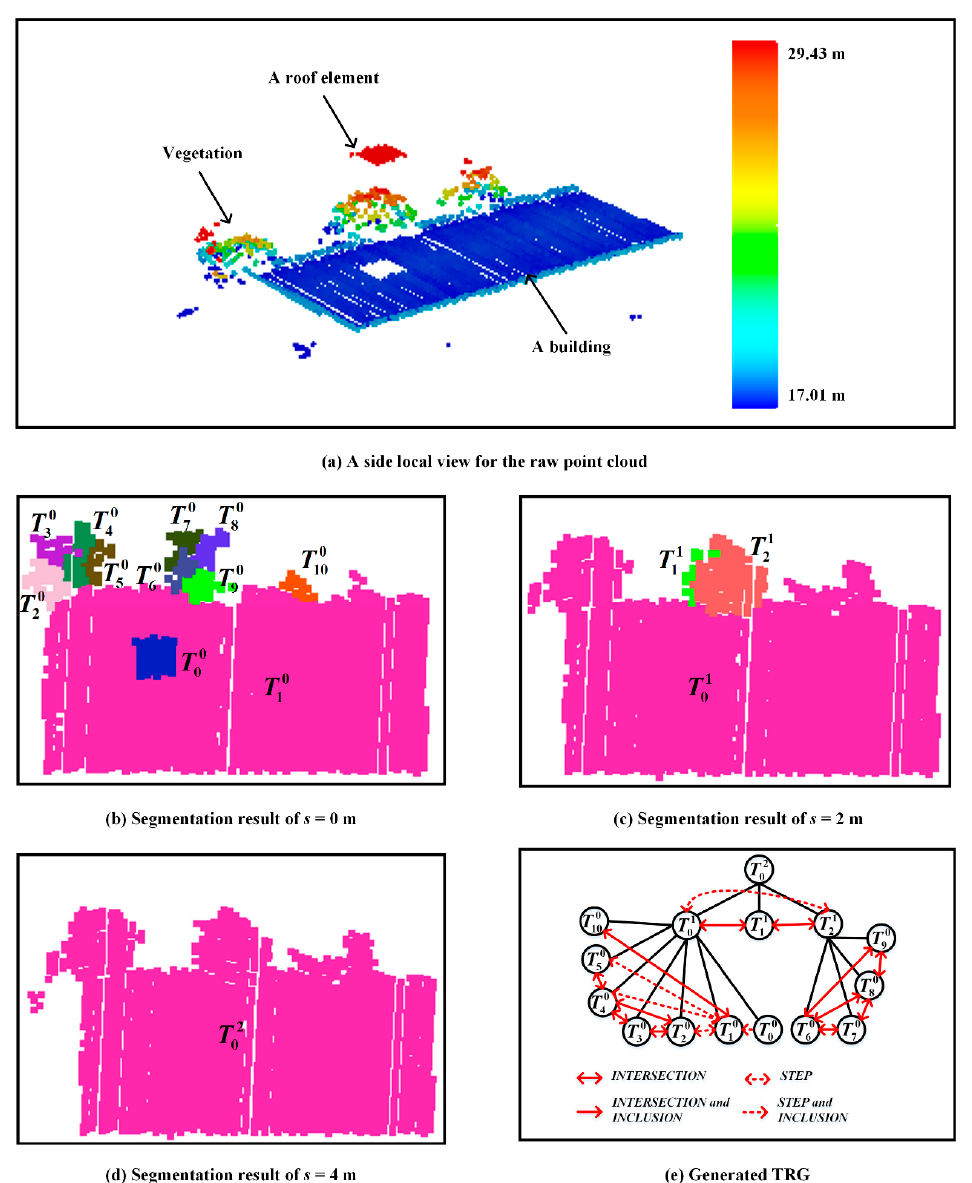
Figure 7. Generating the TRG for the building candidate region B of Figure 6d. ( a ) Raw point cloud; ( b – d ) Segmentation results of three scales. Each segment is dotted in one color, and each segment is annotated with a unique identification; ( e ) Generating TRG according to the method in Section 2.